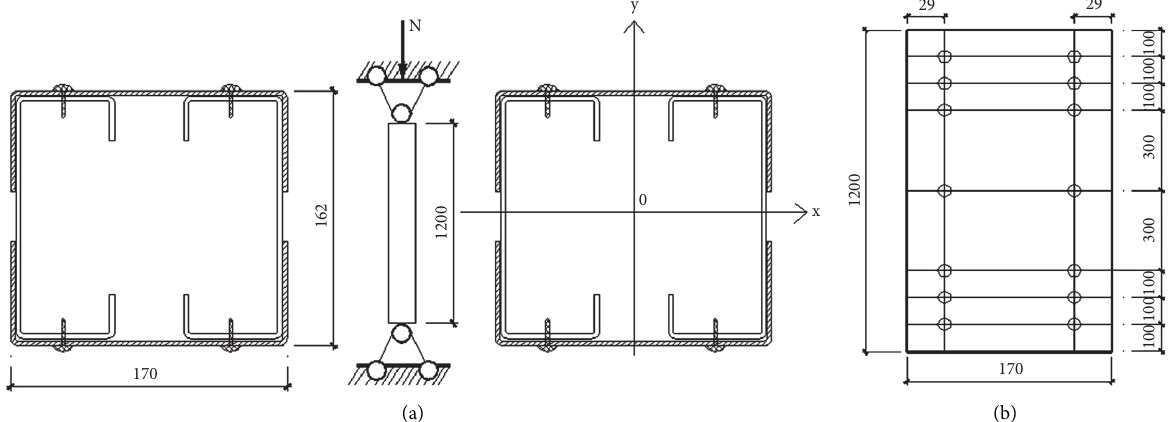
Figure 28: CU-type section: (a) calculation diagram and (b) screw distribution.